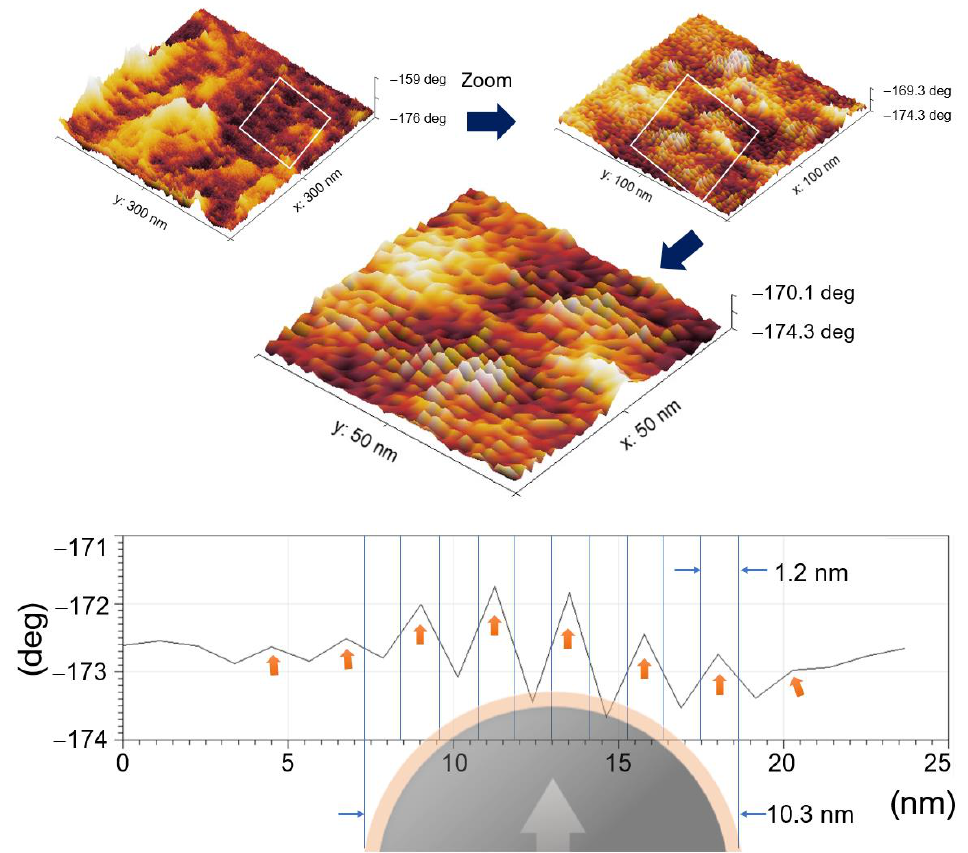
Figure 8. Magnetic domains of G-M@T samples.